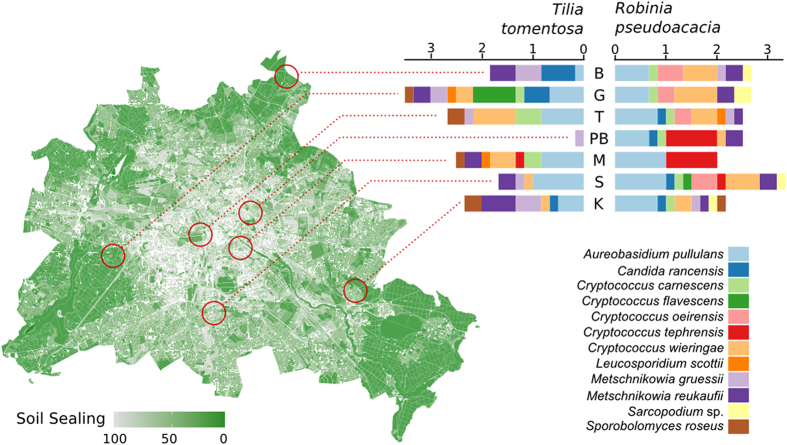
Summed relative incidences of the 12 most abundant yeast species occurring in the different districts of Berlin (for clarity we do not present the relative abundance of all found yeast species).The x-axes show the stacked relative incidences in the six sampled trees per site, calculated separately for each yeast species. The letters refer to the different sampling locations in Berlin (see Table 1 for full detail). We show a Berlin map containing soil sealing information (this was the urbanization factor significant at the 1000 m scale, see Table 2 for further detail) (The figure was made with function ggmap in package “ggmap”38 in R36).